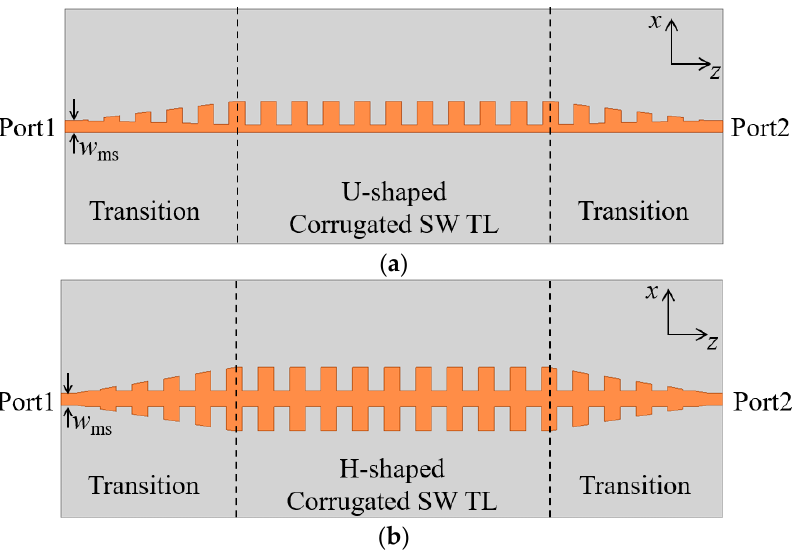
Figure 3. Configuration of the corrugated SWTLs with transitions: ( a ) U-shaped; ( b ) H-shaped.